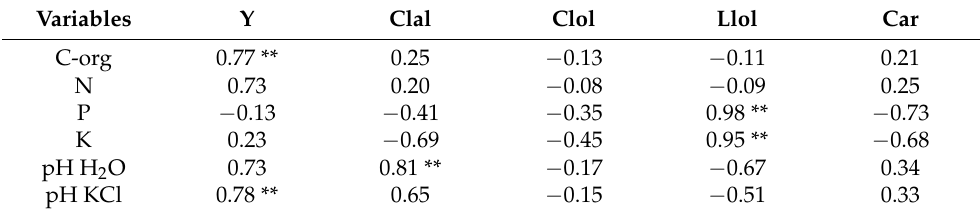
Table 10. Pearson correlation coefficient of kaffir lime leaves essential oil (yield and main composition) and edaphic factor (soil pH and soil macronutrient